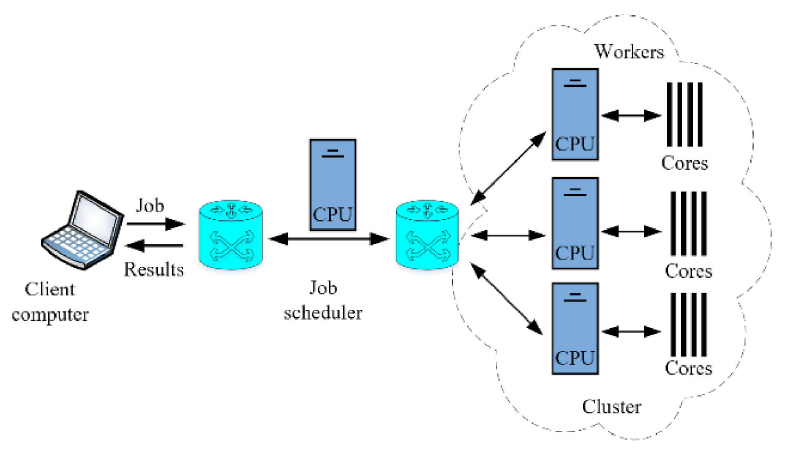
Figure 2. The cluster formation and utilization for parallel